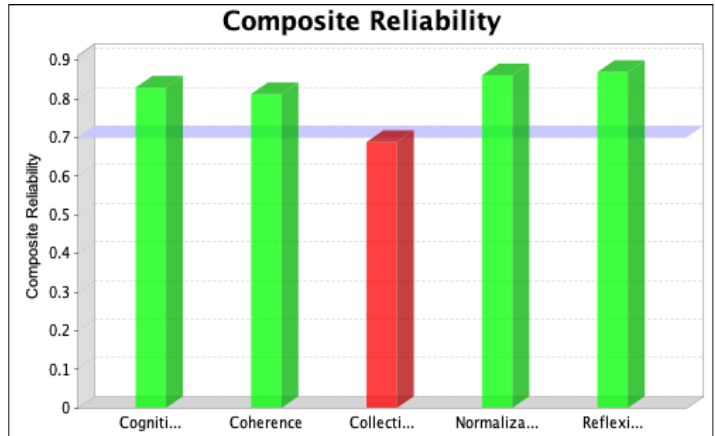
Figure 4. Values of composite reliability in the first iteration.